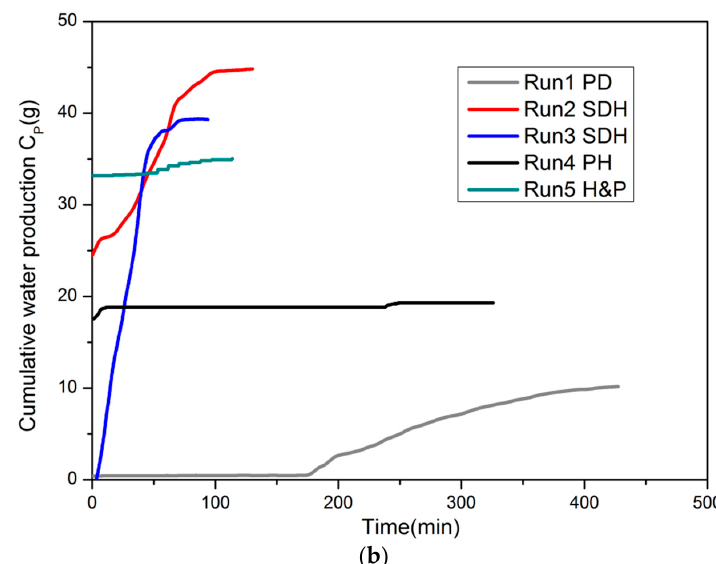
Figure 4. ( a ) The temperature change of T5 in five Runs during the production stage; ( b ) The cumulative water production of five Runs in the production stage.